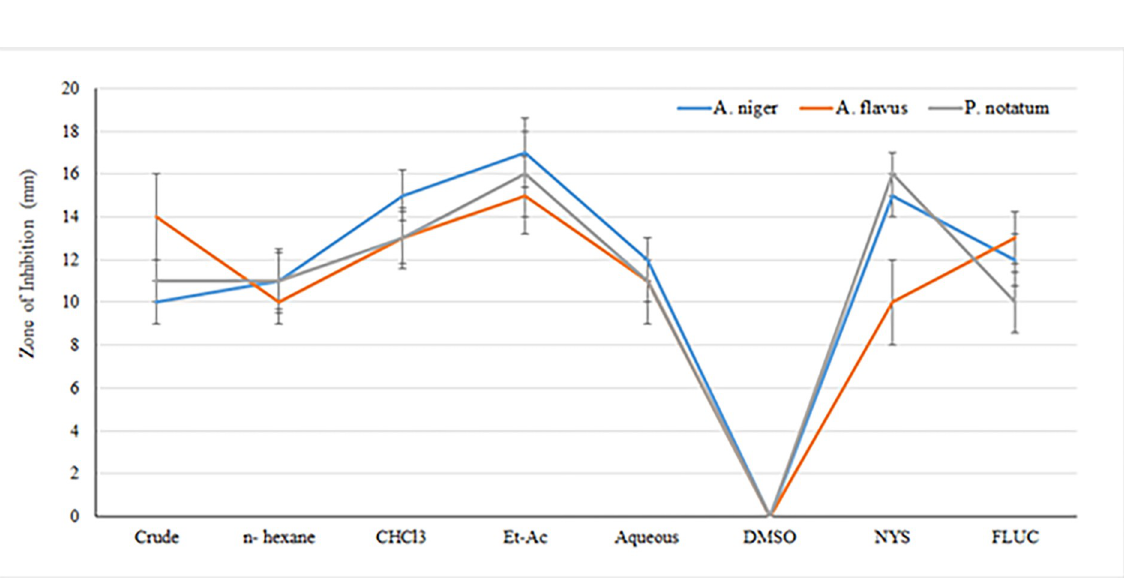
PLOS ONE | https://doi.org/10.1371/journal.pone.0280127 January 6,